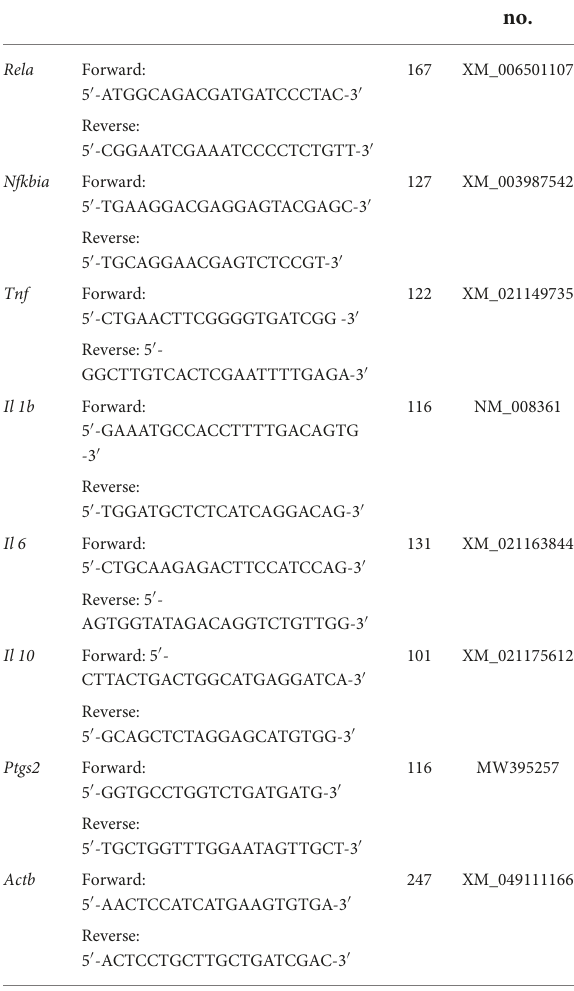
TABLE 3 Sequences of primers used in this